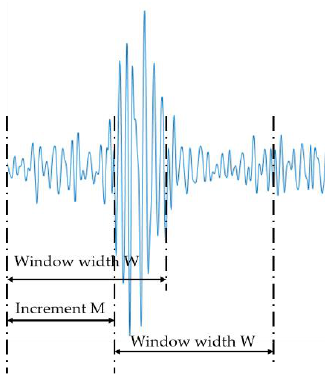
Figure 4. Schematic diagram of sEMG signals